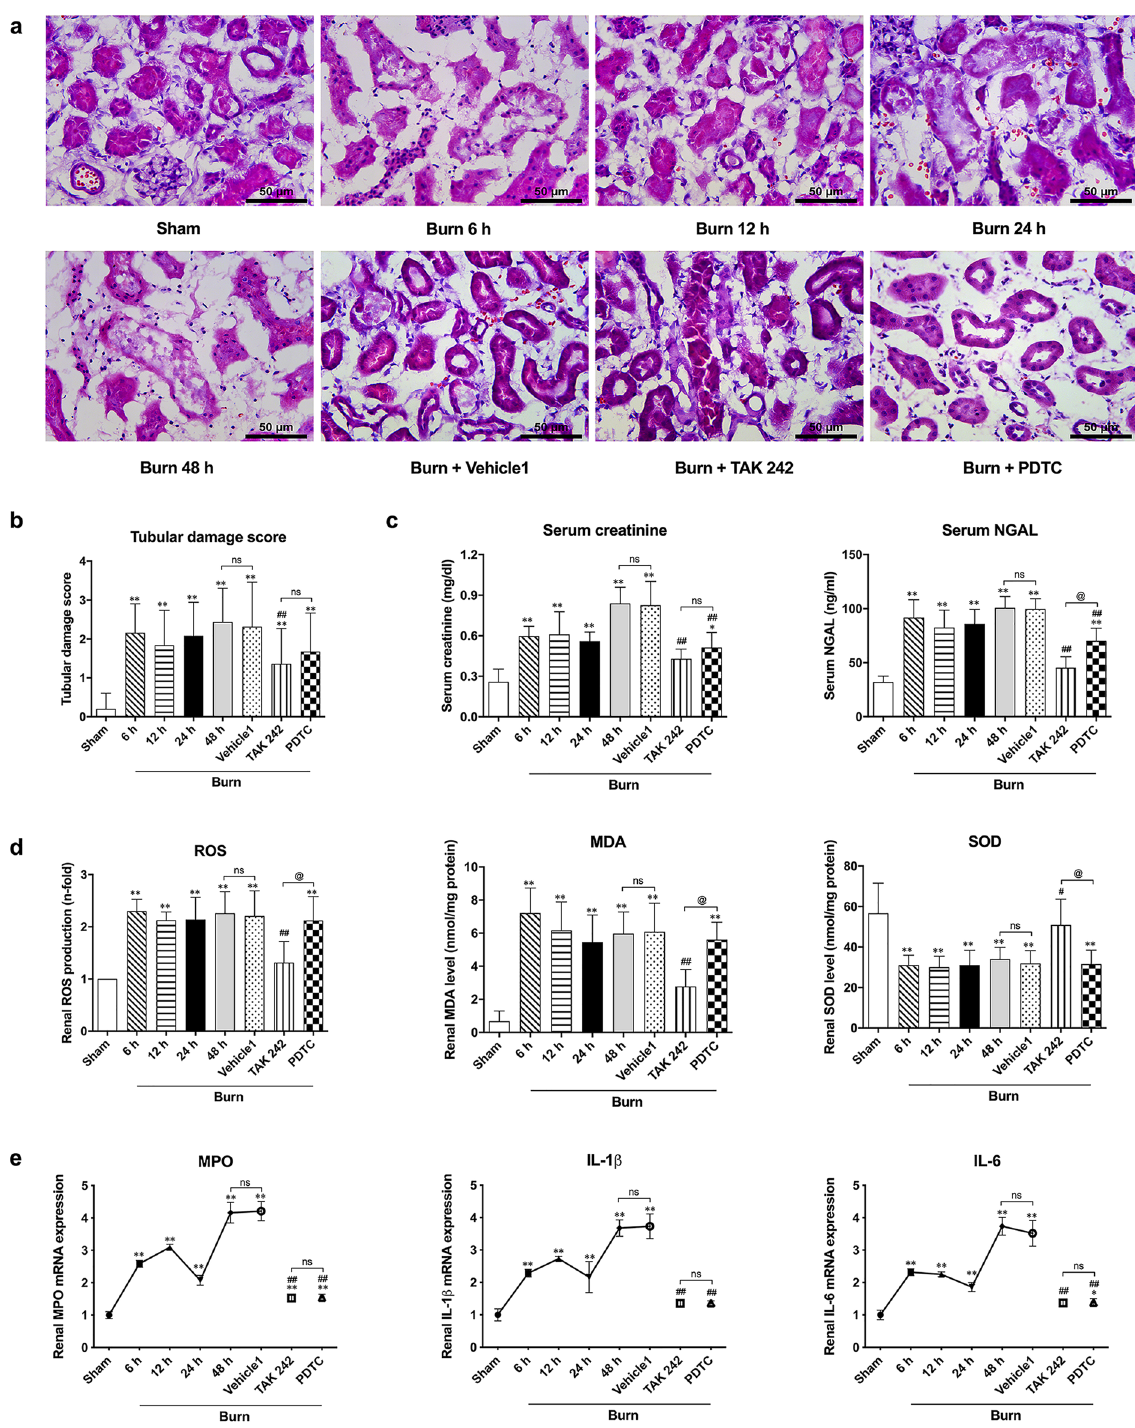
Figure 1. Histological, functional and biological assessments of kidney after burn. ( a ) Representative HE-stained images of renal tissues at a magnification of 200 × ; ( b ) Tubular damage score according to HE-stained slices; ( c ) Blood-based detection of creatinine and NGAL; ( d ) Oxidative stress evaluation based on commercial kits of ROS, MDA and SOD; ( e ) The release levels of inflammatory mediators after insults. n = 8 for each group. The results are expressed as the mean ± SD. * p < 0.05, ** p < 0.01, v.s. sham; # p < 0.05, ## p < 0.01, v.s. vehicle1; @ p < 0.05, ns p >